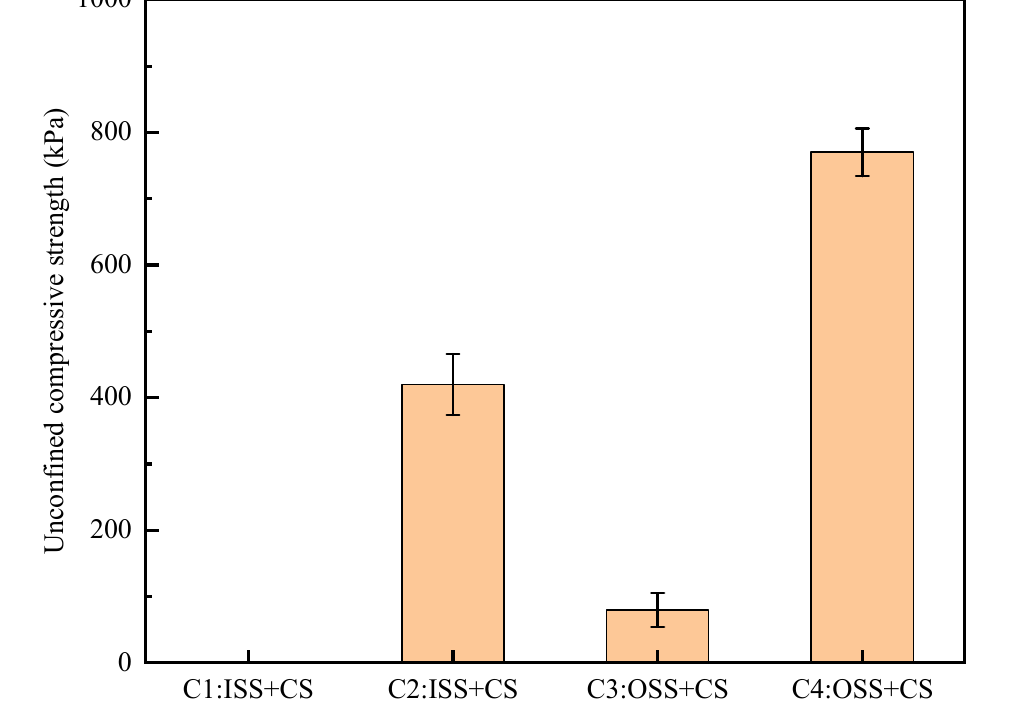
Figure 10. Uniaxial compressive strengths of the samples.